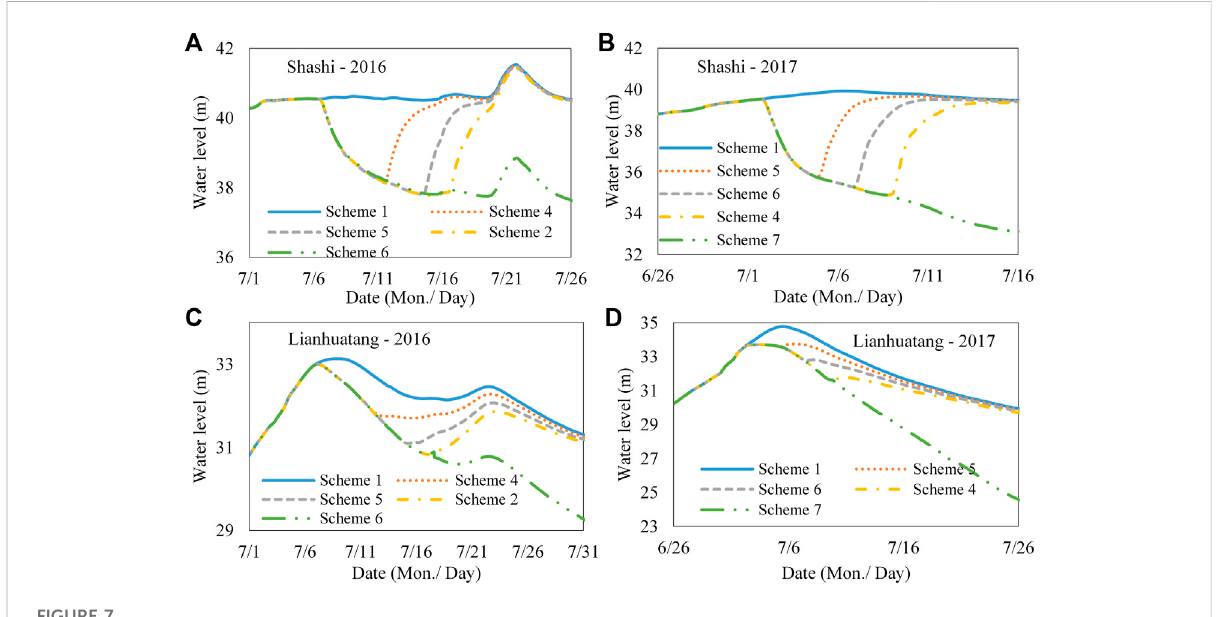
FIGURE 7 The water level processes under same fl ood interception discharges during different period: (A) Shashi — 2016; (B) Shashi — 2017; (C) Lianhuatang — 2016; (D) Lianhuatang — 2017.